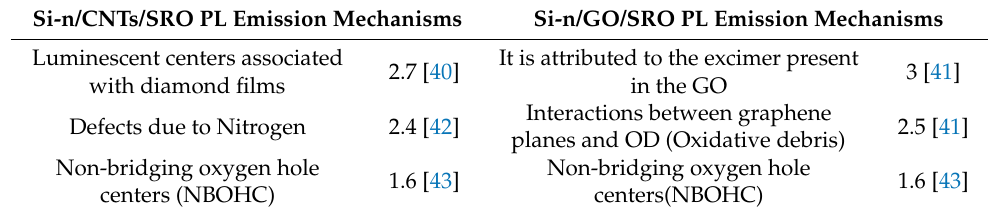
Table 4. Types of defects linked to the position [eV] of the PL peaks of the structures.